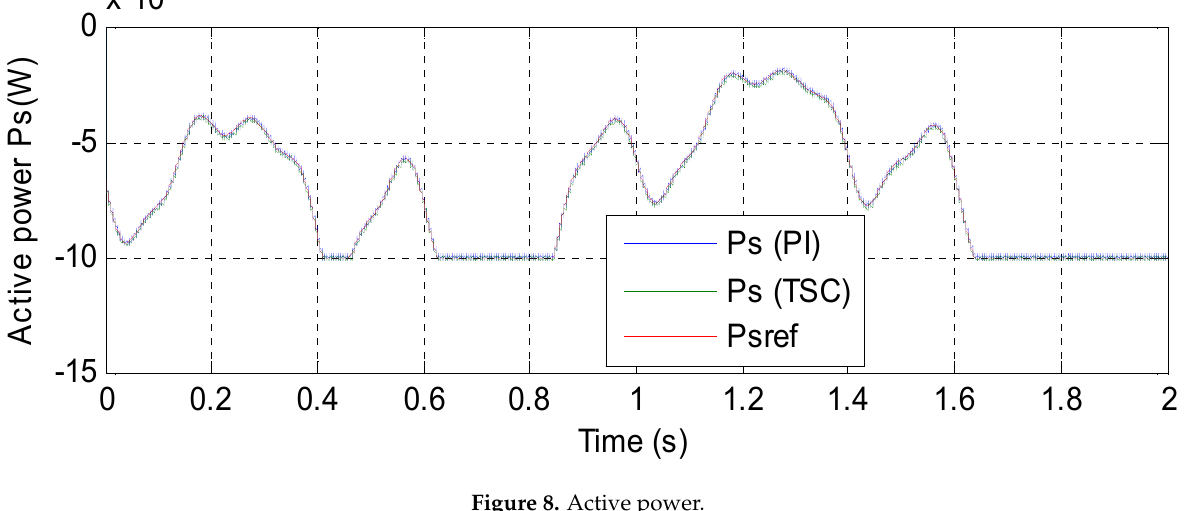
Figure 9. Reactive power. Figure 10. Torque.